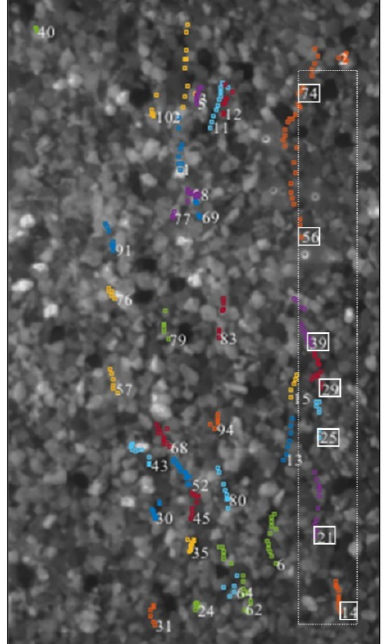
Figure 1. An example of a two-step method.